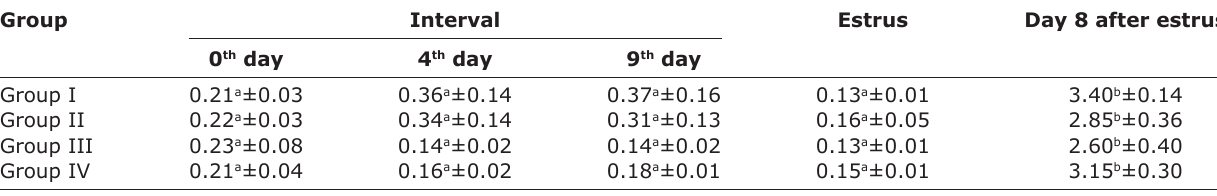
Table-5: Effect of herbal supplementation on serum progesterone (P4) concentration (ng/ml) in delayed pubertal buffalo heifers in various groups and intervals. Group Interval